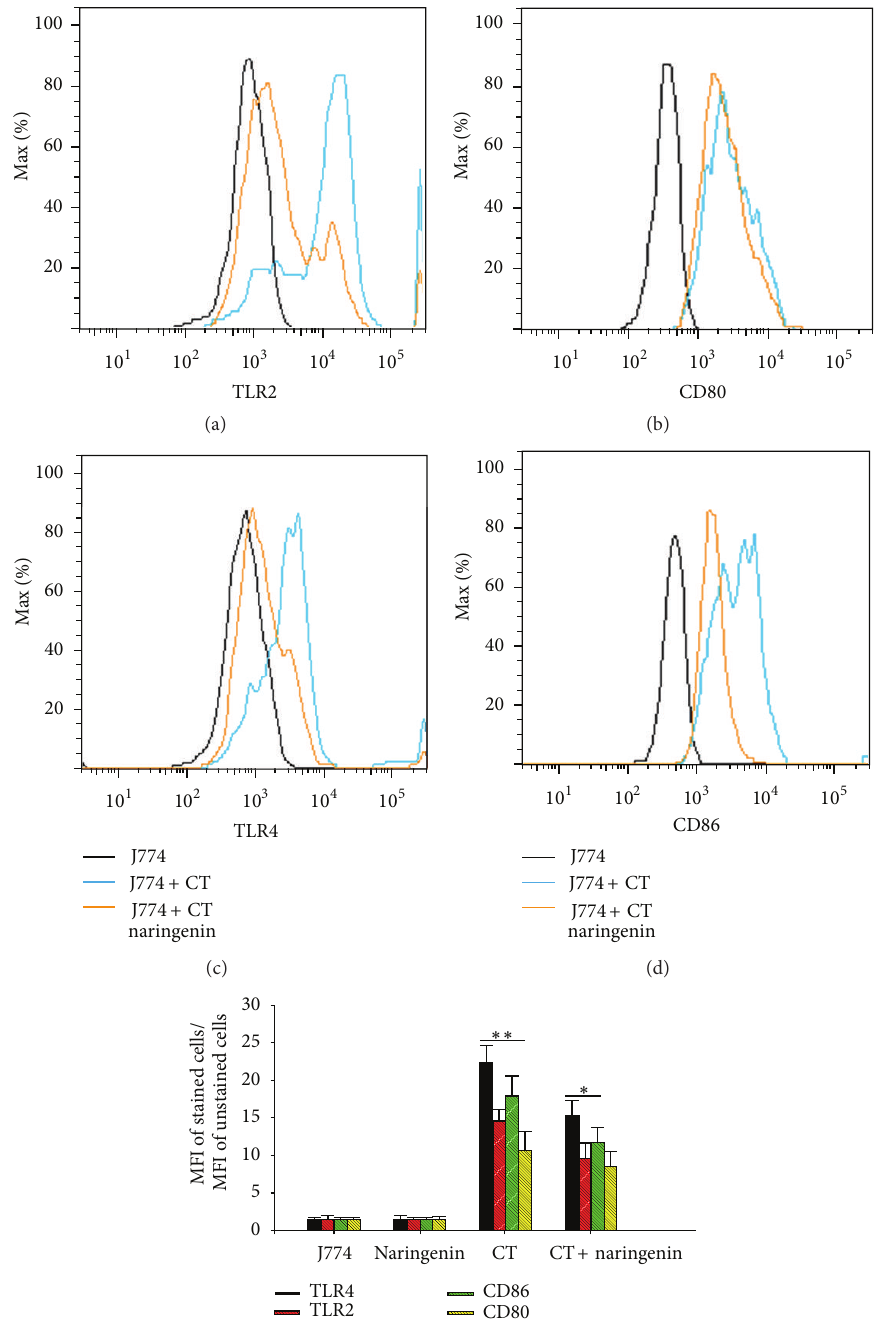
Figure 3: Naringenin downregulates the expression levels of CD80, TLR2, and TLR4 in C. trachomatis infected mouse J774 macrophages. Macrophages (10 6 cells/mL) were seeded in 24-well plates and infected with C. trachomatis (10 5 IFU/well) or left uninfected. After 2-day infection, 1 𝜇 g/mL naringenin was added to cell cultures and 2 days later samples were analyzed by flow cytometry as described in Section 2. Shown are the expression shifts of TLR2 (a), CD80 (b), TLR4 (c), and CD86 (d) and their mean fluorescence intensity (MFI) (e) before and after infection of macrophages with C. trachomatis (CT) in the presence and absence of naringenin. ∗ 𝑃 < 0.05 is considered significant as compared to untreated cells (J774) and to cells treated with CT or CT + naringenin. The data are representative of two separate